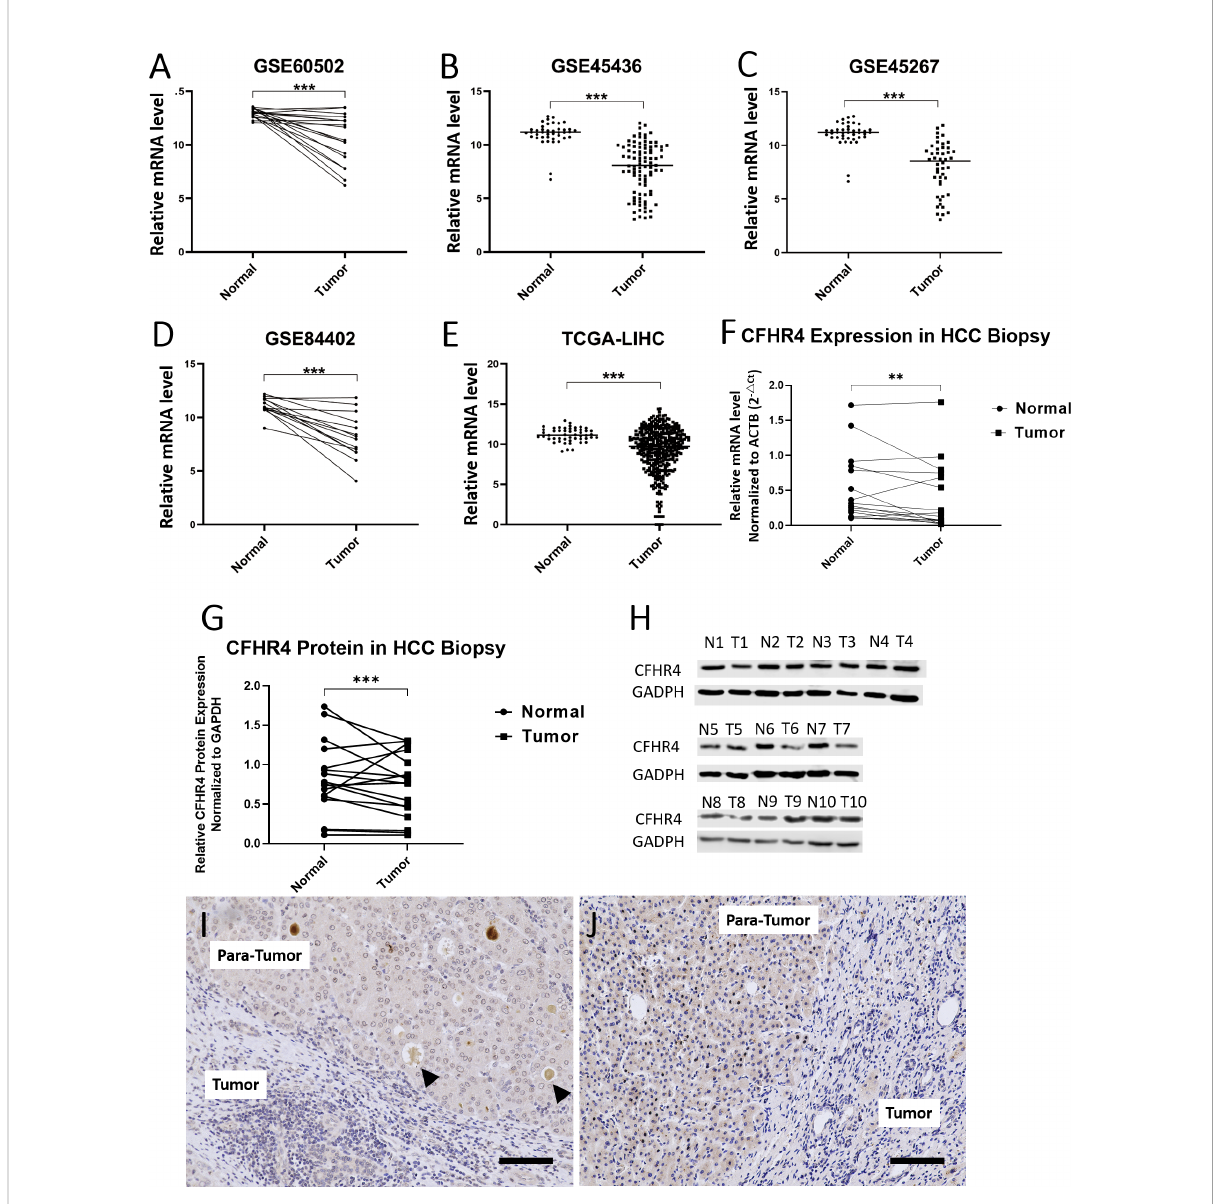
FIGURE 2 CFHR4 expression levels between tumor and non-tumor tissues in HCC patients. (A – E) Analysis of mRNA transcriptional level of CFHR4 in normal and tumor tissues using data from the GEO and TCGA-LINC database; (F, G) Comparisons on the mRNA and protein levels of CFHR4 between tumor and non-tumor tissues from 17 patients; (H) Western Blotting was used to analyze and compare the expression of CFGR4 protein in 10 HCC tissues and adjacent non-tumor tissues, respectively GAPDH was corrected as an internal reference. (I, J) Immunohistochemical staining of CFHR4 on the HCC and para-tumor tissue. “ T ” represents the HCC tissues, and “ N ” the non- tumor tissues. The same number after “ N ” and “ T ” indicates the same patient. Black arrows represent the dissociative CFHR4 secreted into circulation through intrahepatic veins. Scale: 100 m m, P < 0.01 **, P < 0.001